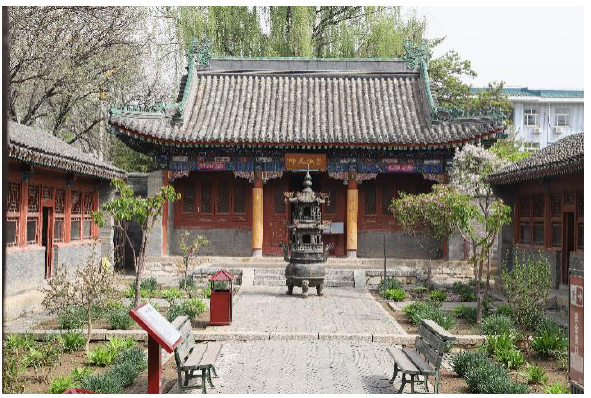
Figure 8. LuBanShrine